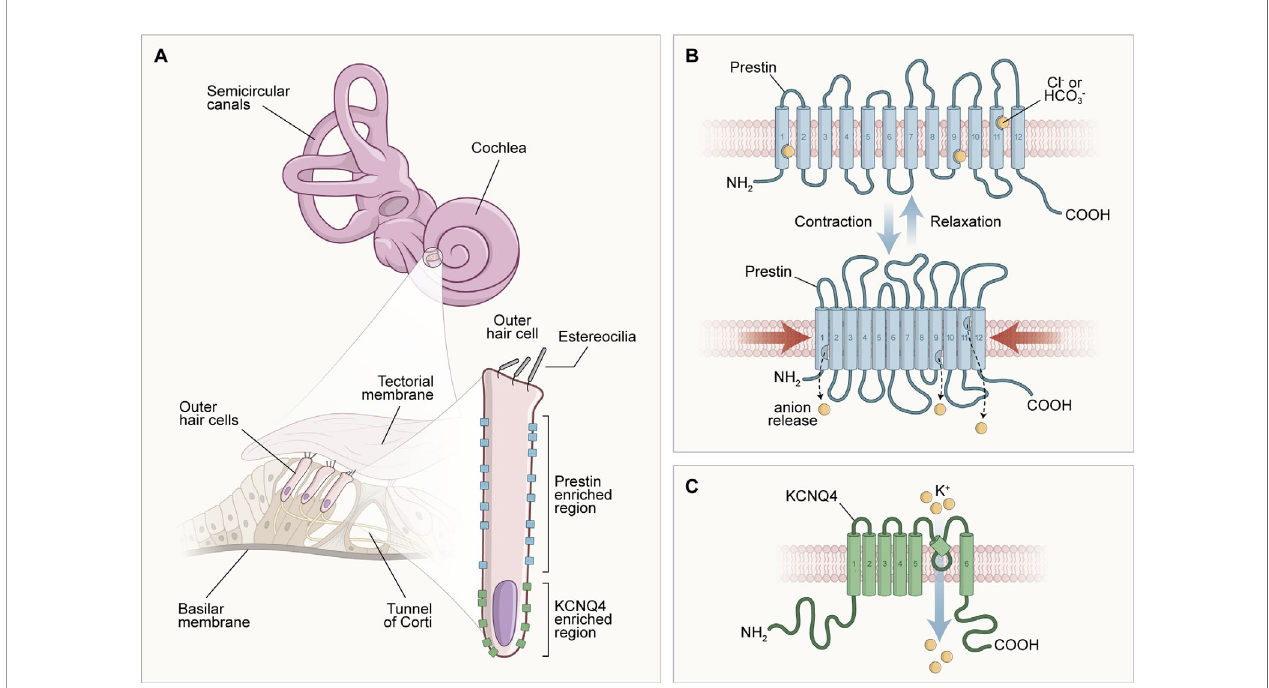
FIGURE 1 | Scheme of the morphological con fi guration and special distribution of transmembrane proteins responsible for the endolymphatic potential (KCNQ4) generation and cochlear electromotility (prestin). In (A) , the structures of the inner ear are illustrated in different parts: at the top of the image, there are the cochlea and semicircular canals, structures that compose the inner ear macroscopically; to the left of the image, in a microscopic analysis, there is the spiral organ (Tunnel of Corti) formed of the tectorial membrane, supporting and sensory cells; and to the right of the image, the morphology of the outer hair cell can be observed, delimiting the molecular location of the transmembrane proteins prestin (lateral) and KCNQ4 (basal). In (B) , it is possible to observe the unique arrangement of the prestin protein and its physiology. Prestin is involved with the motor function of outer hair cells (OHC). This activity occurs when OHCs are depolarized through the in fl ux of K+ positive electrical charges after a sound stimulation, creating a positive intracellular environment that favors the displacement of Cl- anions from the prestin's binding sites into the cytoplasm. This electrical charge movement causes a shortening of prestin and, consequently, a reduction in the size of the OHC, characterizing the active mechanism and the bio-electromotility of the OHC that occurs in the absence of calcium and ATP. In (C) , after depolarization, an OHC enters the repolarization and hyperpolarization stage due to the exit of cations in the basal portion of the potassium channels formed by the transmembrane protein KCNQ4, which contributes to the generation of the endolymphatic